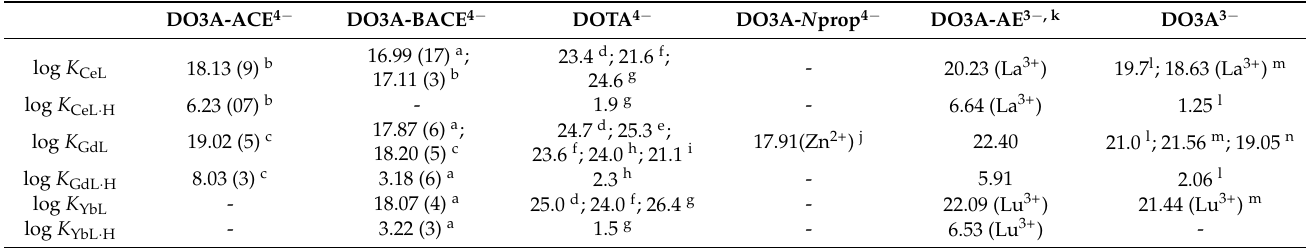
Table 3. Stability constants of DO3A-ACE 4 − , DO3A-BACE 4 − , DOTA 4 − , DO3A 3 − , and DO3A-Nprop 4 − with some Ln 3+ ions (25 ◦ C).